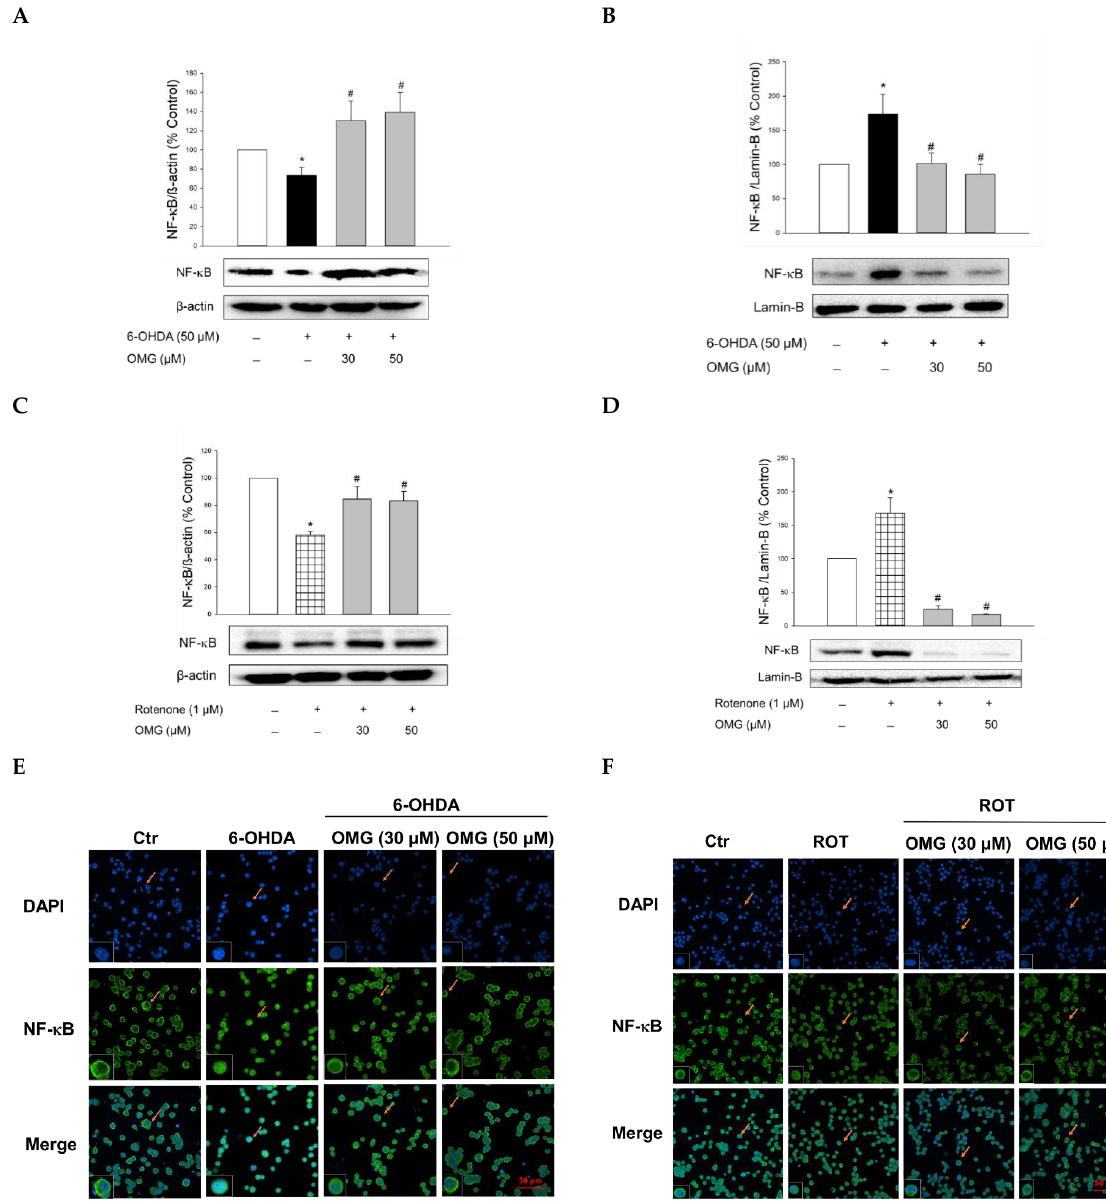
Figure 7. Inhibition of NF- κ B nuclear translocation by OMG in 6-OHDA- or rotenone-treated PC12 cells. PC12 cells were pretreated with OMG at 30 and 50 µ M for 4 h and subsequently exposed to 6-OHDA or rotenone for 6 h. ( A – D ) Cytosolic and nuclear levels of NF- κ B were evaluated by western blotting using anti-NF- κ B antibody, as described in the Materials and Methods section. Band intensity was quantified by densitometric analyses, and nuclear and cytosolic levels of NF- κ B were normalized to lamin-B and β -actin, respectively. Data are displayed as the mean ± SEM from at least three independent experiments. *, p < 0.05 and # , p < 0.05 vs. the vehicle-treated control and 6-OHDA- or rotenone-treated cells, respectively. ( E , F ) Immunocytochemical analysis was carried out using DAPI and anti-NF- κ B antibodies, as described in the Materials and Methods. Representative images are shown. The arrow in each image indicates the magnified cell shown in the inset (scale bars in ( E , F ), 30 and 50 µ m, respectively). NF- κ B, nuclear factor-kappa B; OMG, omarigliptin; 6-OHDA, 6-hydroxydopamine; ROT, rotenone; Ctr, control; DAPI, 4 (cid:48) ,6-diamidino-2-phenylindole